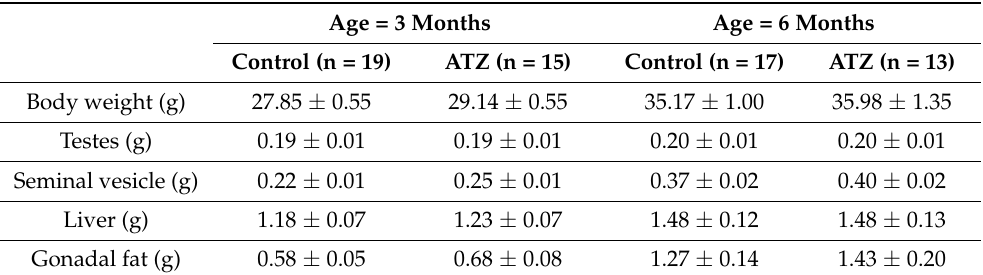
Table 1. The effect of atrazine-treated water (0.02 ng/mL) on body weight and organ weights (g) at 3 and 6 months of age in the F1 cohort. No significant differences were found between the control and ATZ treatment for all parameters. Data are mean ± SEM, with >7 L per treatment, per age cohort.